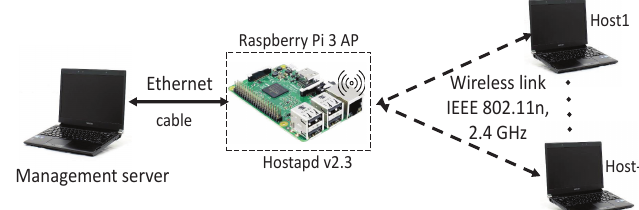
Figure 4. Testbed topology for iperf